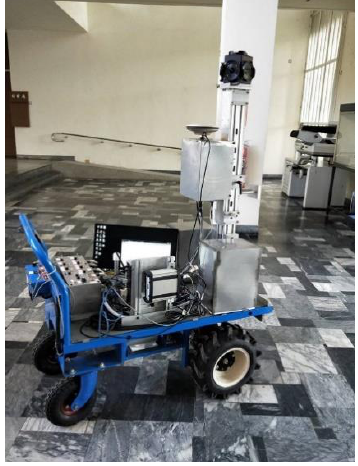
Figure 2. The indoor mobile mapping